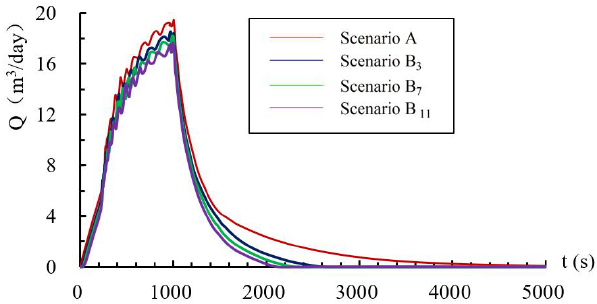
Figure 6. Spring hydrographs with different pumping rate at W3. (Q is spring discharge, m 3 /day).